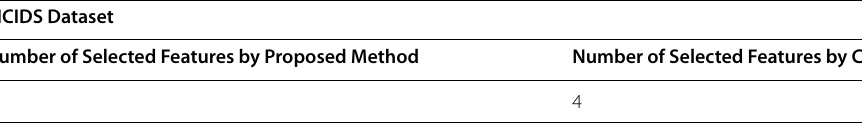
Table 19 Number of selected feature by CFS and proposed method on CICIDS dataset CICIDS Dataset